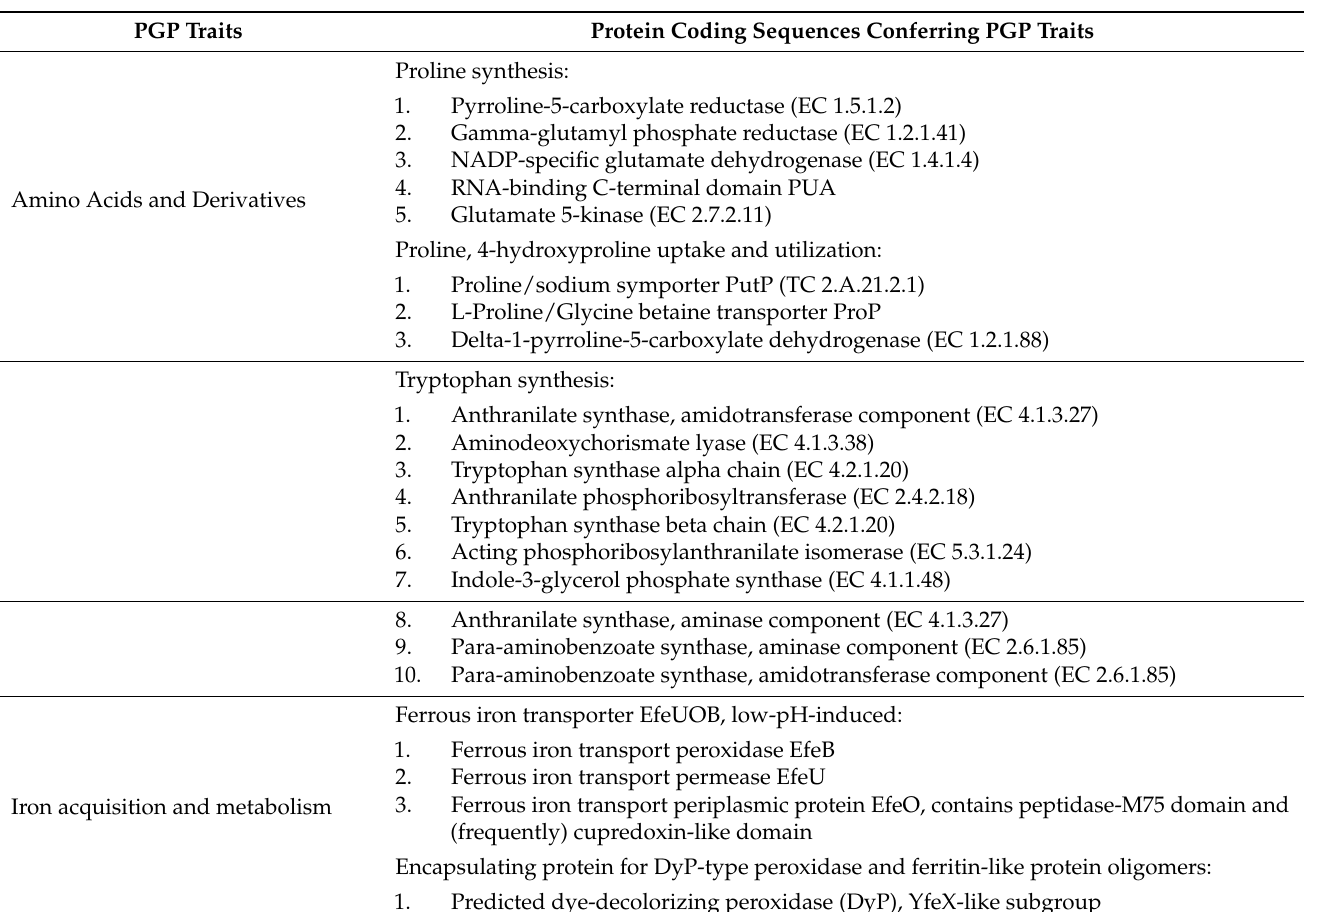
Table 2. Protein coding sequences related with plant growth promoting traits of D. abyssi MT1.1 T . PGP Traits Protein Coding Sequences Conferring PGP Traits